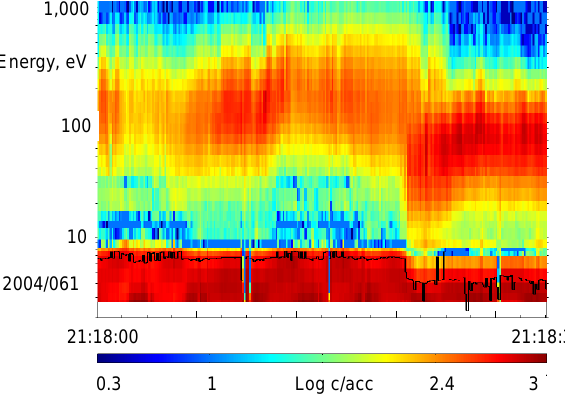
Figure 13. Example of energy-pitch angle-time plot to demonstrate the effectiveness of Fig. 13. Example of energy-pitch angle-time plot to demonstrate the ground-based pitch angle production (September 03 rd 2004, PEACE data from TC1) effectiveness of ground-based pitch angle production (3 September 2004, PEACE data from TC-1).